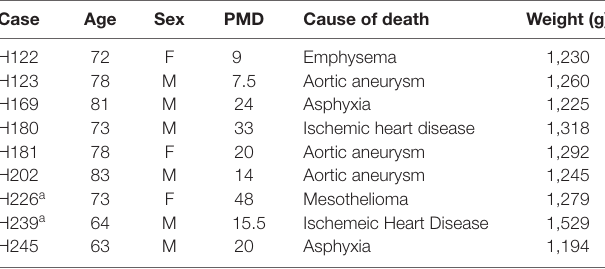
TABLE 1 | Normal human brain case details used for